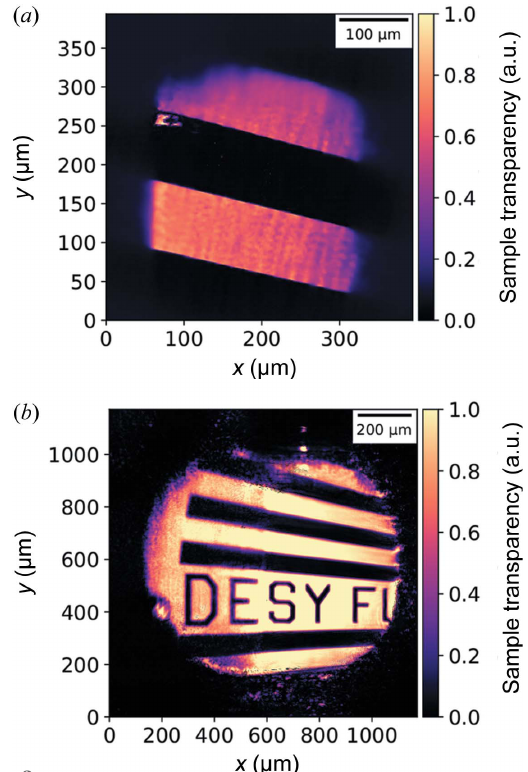
Figure 3 The sample reconstruction transparency of the sample from ( a ) the data measured with the PERCIVAL detector and ( b ) during the experiment described by Kharitonov et al.